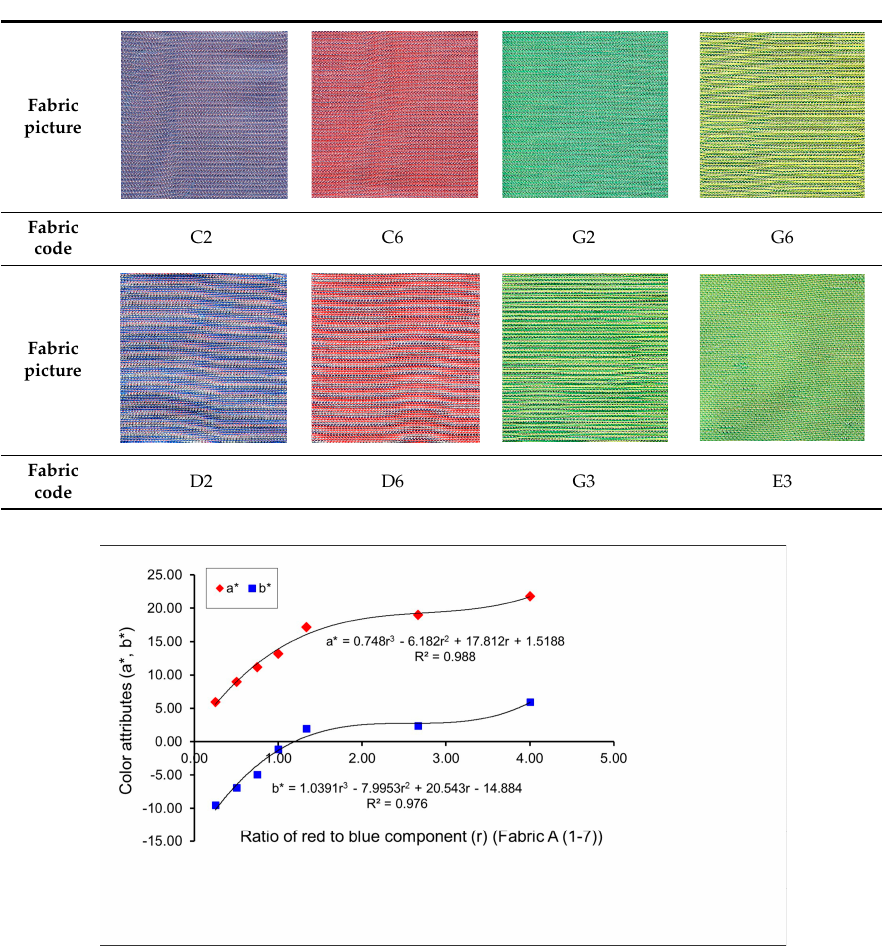
Figure 2. Effect of the proportion of blue-red weft yarns on mixed color attributes ( a * and b *) of fabrics without a regulating layer.